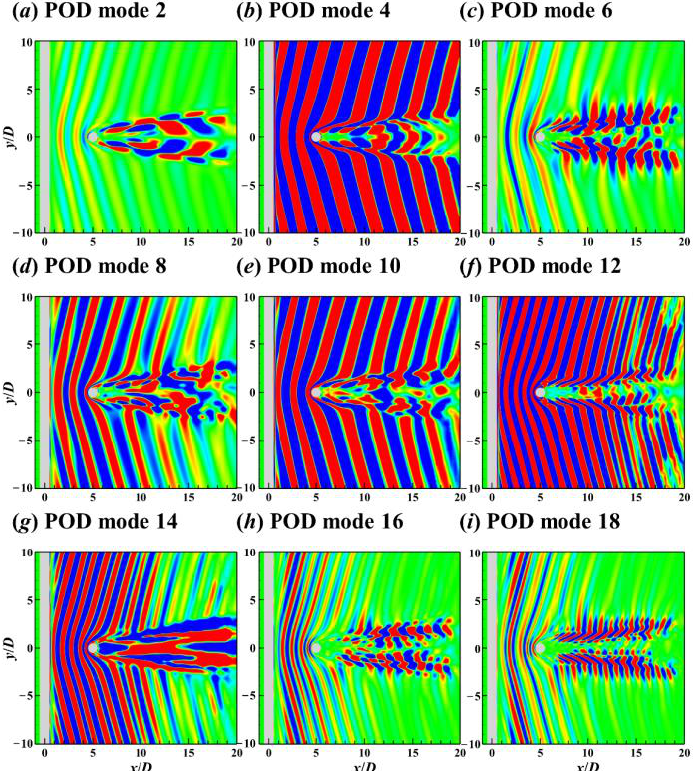
Figure 27. Contours of the 2nd ( a ), 4th ( b ), 6th ( c ), 8th ( d ), 10th ( e ), 12th ( f ), 14th ( g ), 16th ( h ), and 18th ( i ) POD modes on the xz plane for the flow around the two crossing cylinders in 90° arrangement.